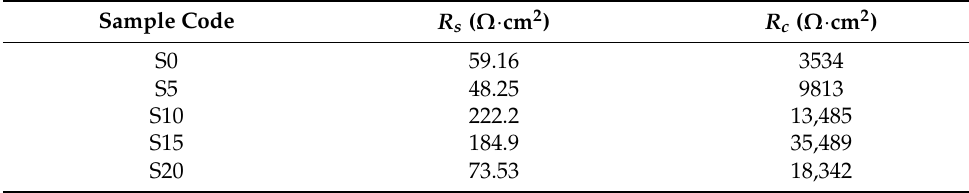
Figure 9. Nyquist plots of all samples.